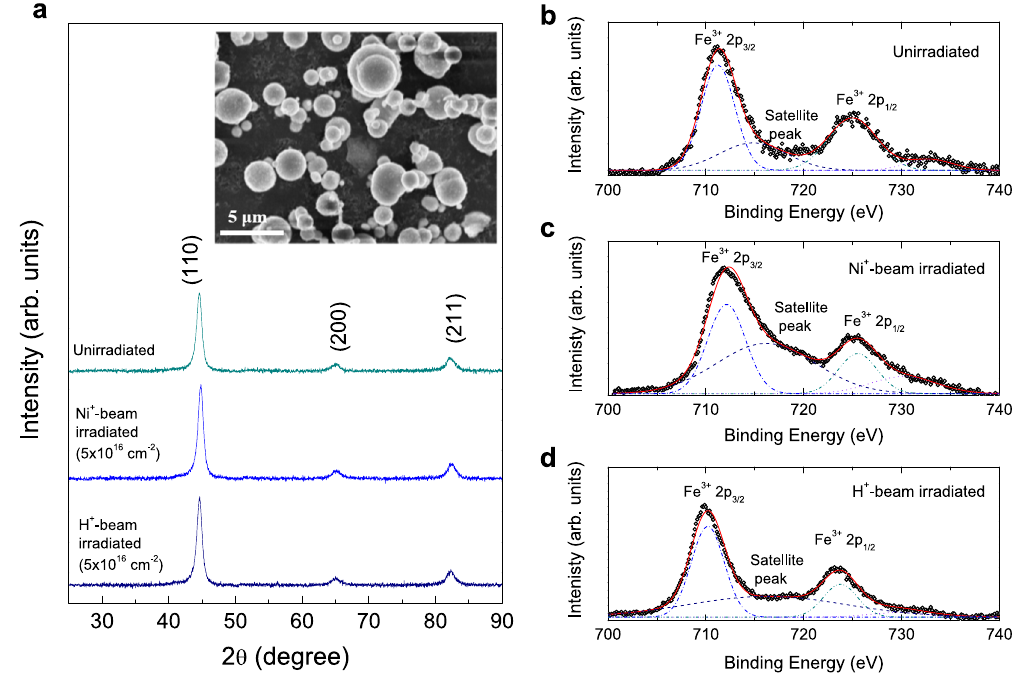
Figure 1. ( a ) XRD pattern of unirradiated, Ni + -beam-irradiated, and H + -beam-irradiated CI powders. The inset shows the SEM images of the size and surface morphology of the unirradiated CI particles. XPS spectra of Fe 2p for ( b ) unirradiated, ( c ) Ni + -beam-irradiated, and ( d ) H + -beam-irradiated CI